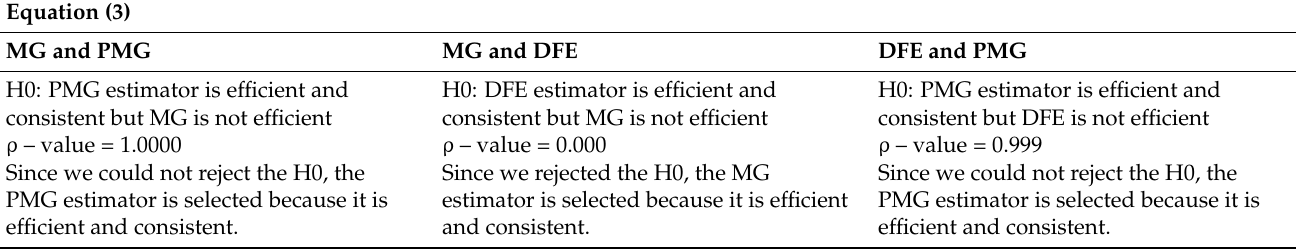
Table 14. Hausman tests for model 3.